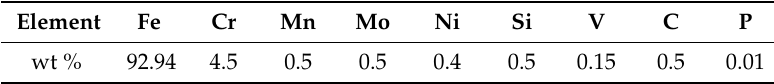
Table 1. The chemical composition of Cr5VMo steel.